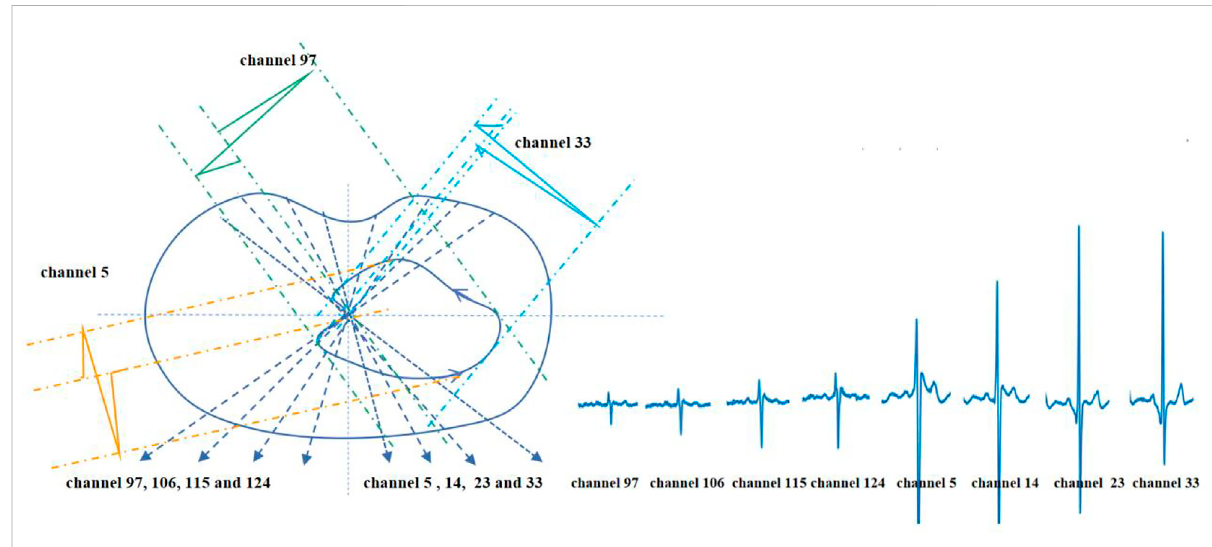
FIGURE 6 Projection and waveform formation of the transverse plane vectorcardiographic loop of